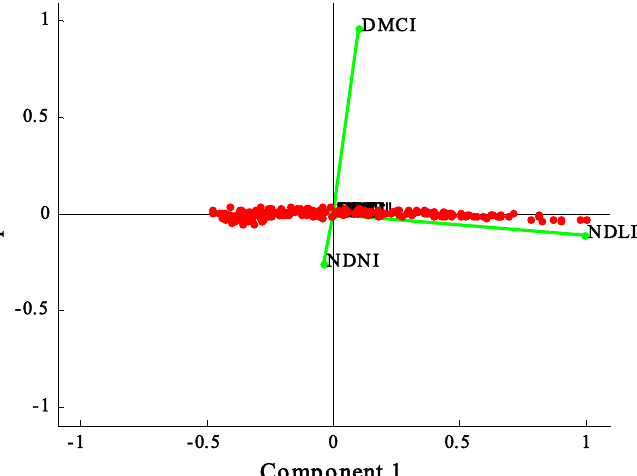
Figure 4. View of the HyMap data and the original metric variables in the space of the first two principal components.